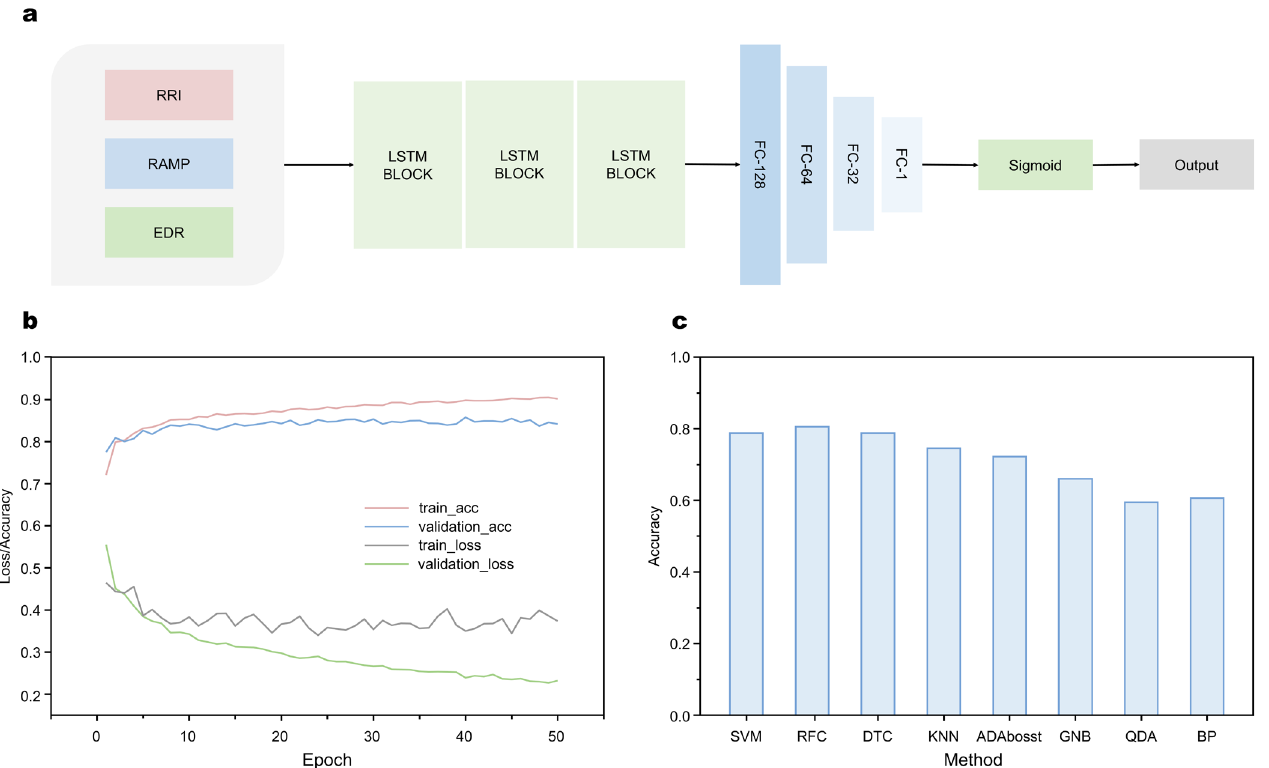
Figure 4. Structure and performance of SAHS detection system. ( a ) Structure of LSTM-RNN. ( b ) Loss/accuracy versus epoch for train and validation sets. ( c ) Comparison of different methods in terms of accuracy.